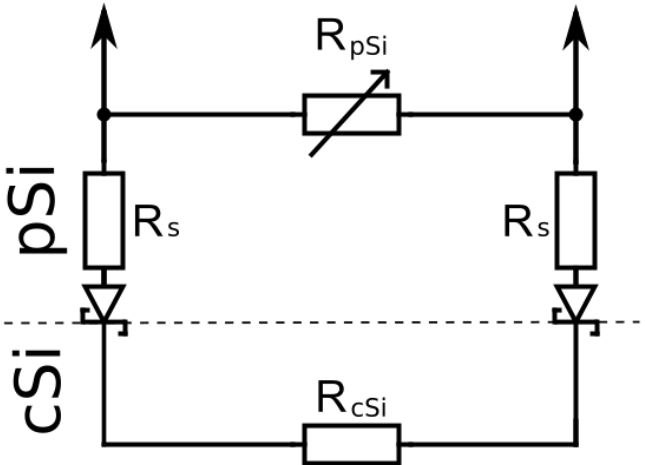
Figure 9. Proposed equivalent circuit of the sensors presented in this work. The resistance between the porous Si layer (pSi) and the crystal layer (cSi) is shown as R s . The resistance of the crystal layer is shown as R cSi , while R pSi is the proposed variable resistance between the contacts shown with arrows. The dashed line marks the boundary between the porous and crystalline layers. See Section 4 for